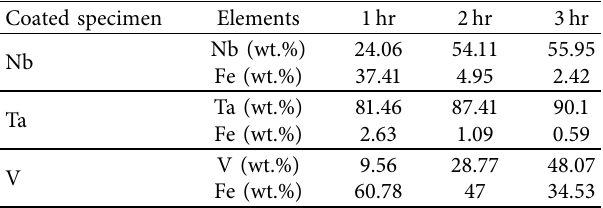
Table 9: Weight % of nanocoated elements corresponding to Fe present on the 316L SS substrate surface at diferent sputtering times using the EDS